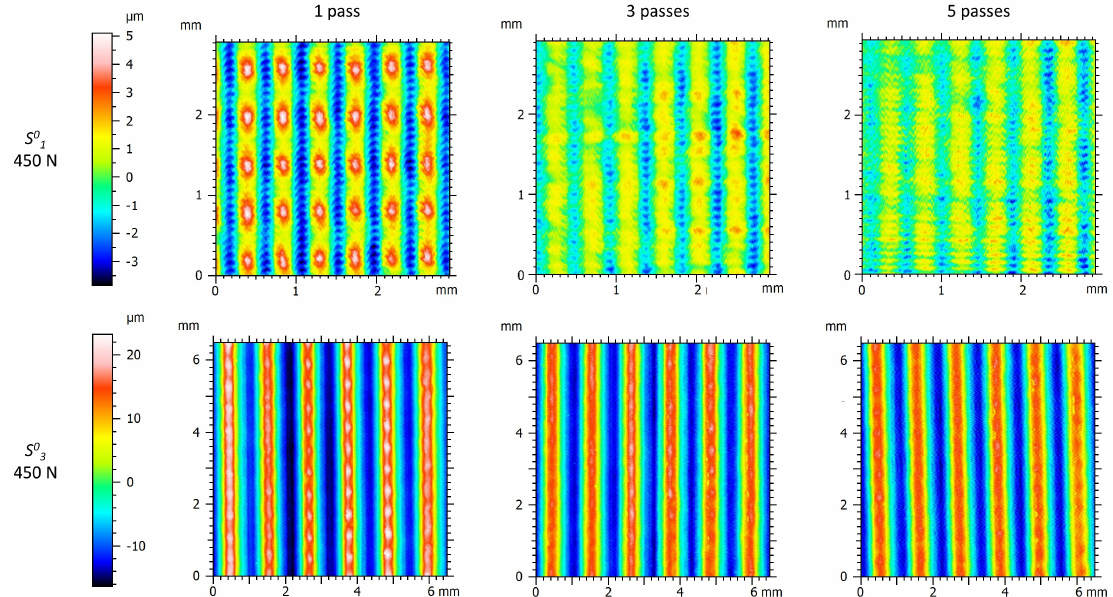
Figure 5. Pseudo-color view of S 0 surfaces burnished with 450 N, and one pass (#21), three passes (#23) and five passes